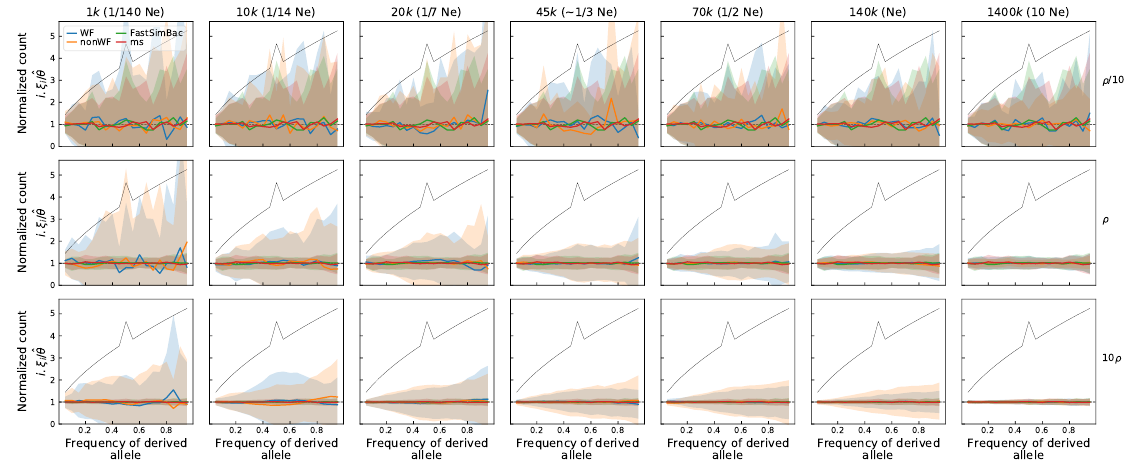
Figure S5 – The normalized Site Frequency Spectrum (SFS) for different numbers of forward-simulated generations and recombination rates. The shaded areas represent standard deviation. The black lines represent the expected standard deviation for the Wright-Fisher model without recombination. Ne =140 000, λ = 12200 bp and